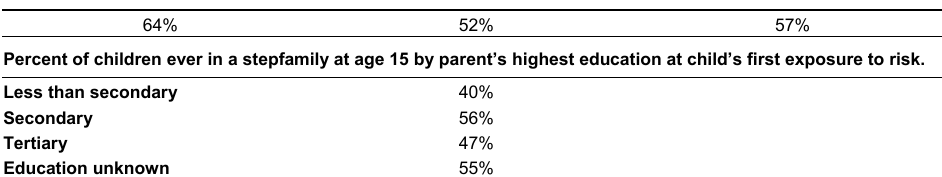
Table 2 : Descriptive statistics: Dependent variable, Children ever in a stepfamily Percent of children ever in a stepfamily at age 15 by sex of child. Girls Boys Both sexes 60% 55% 57% Percent of children ever in a stepfamily at age 15 by parent’s sex. Men Women Both sexes